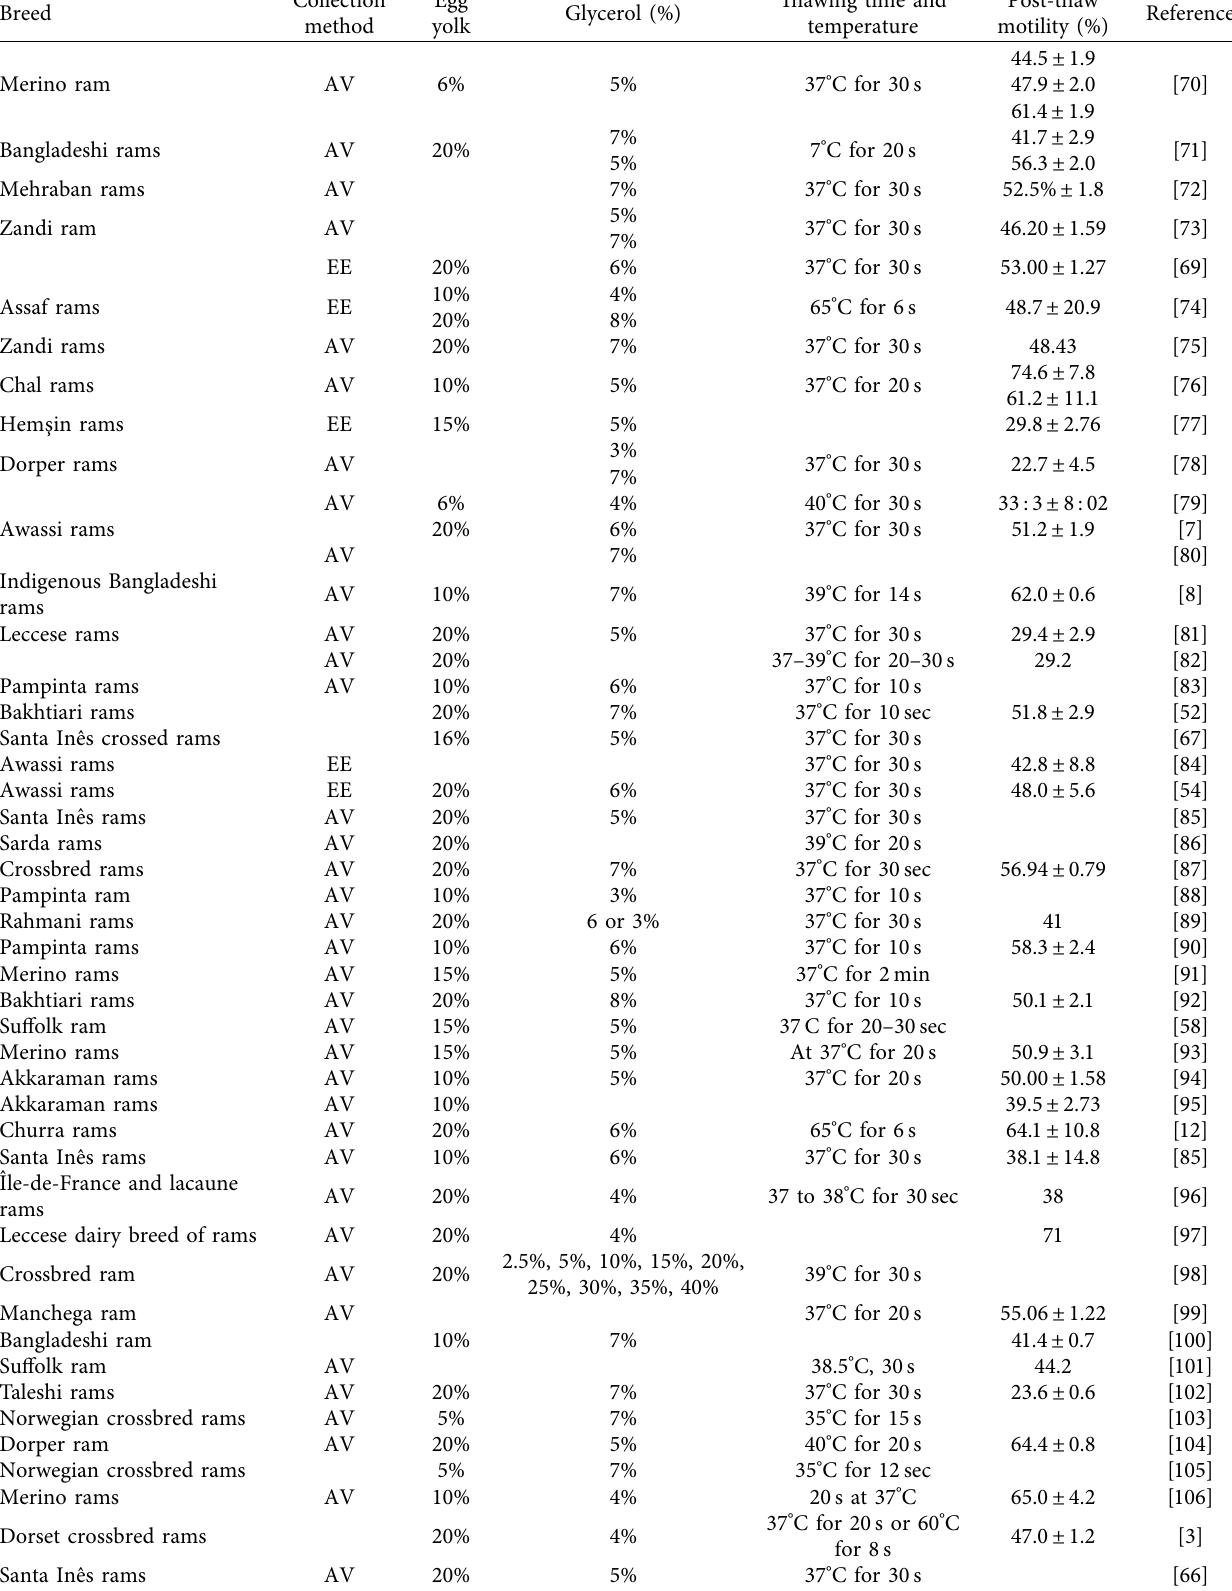
Table 1: Effects of cryoprotectants and thawing temperature on Post-thaw sperm motility of ram